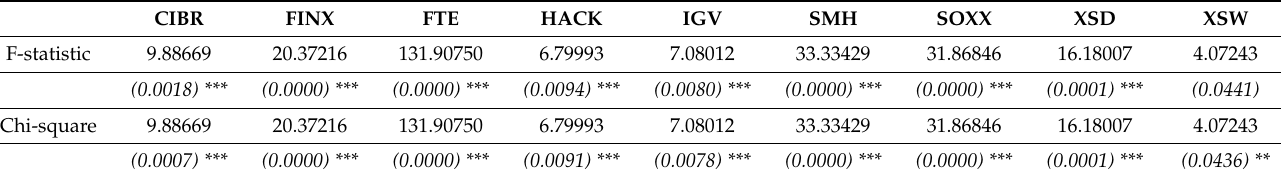
Table A8. WALD Test for the LOG(SIGM) coefficient.